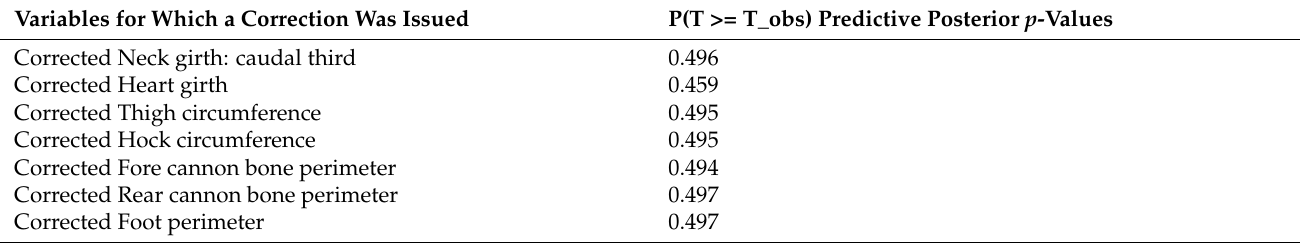
Table 5. Predictive Posterior p -Values (pppvalues) for correction models comprising digital measure- ments and live body weight, except for foot perimeters, for which only digital measurement was used as a regressor to estimate for on-field zoometric measurements in Canarian